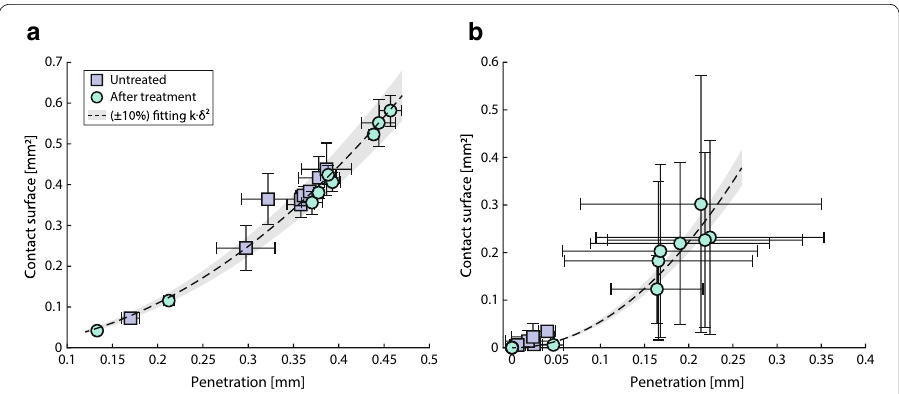
Fig. 5 Contact surface in sandstone and granite. The contact surface area variation (see also Fig. 2c.5) during the test is shown for Rorschach sandstone ( a ) and Grimsel granite ( b ) as a function of tool penetration into the rock. Untreated and post-treatment conditions are indicated by violet squares and green circles, k δ 2 , where respectively. The data are correlated by parabolic functions (dashed curves) of the type S c = · S c is the contact surface, δ is the penetration depth, and the constants are empirically found here, and are 2.86 for Rorschach sandstone and k 5.75 for Grimsel granite. The 10% ranges are shown by given as k = = ± the gray-shaded regions in a and